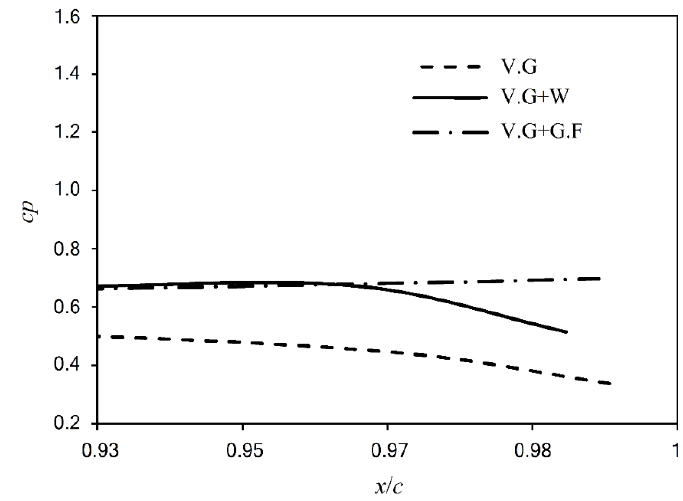
Figure 16. Pressure coefficient a stall angle of attack on the pressure side around the airfoil trailing edge for the airfoil equipped with VGs in the presence of Gurney flap and tailing-edge wedge